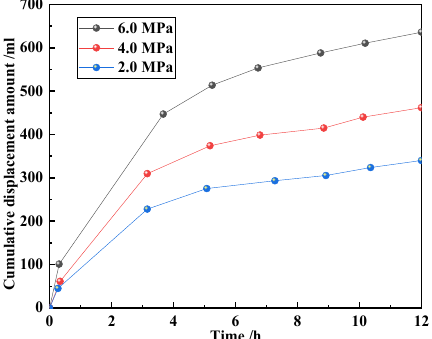
Figure 3. The curve of CH 4 cumulative displacement.